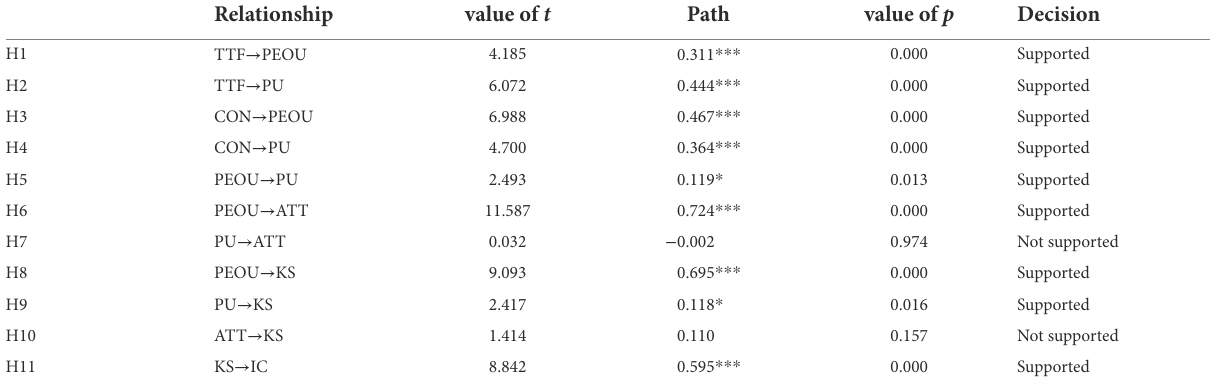
TABLE 9 Test of hypotheses in the refined model.